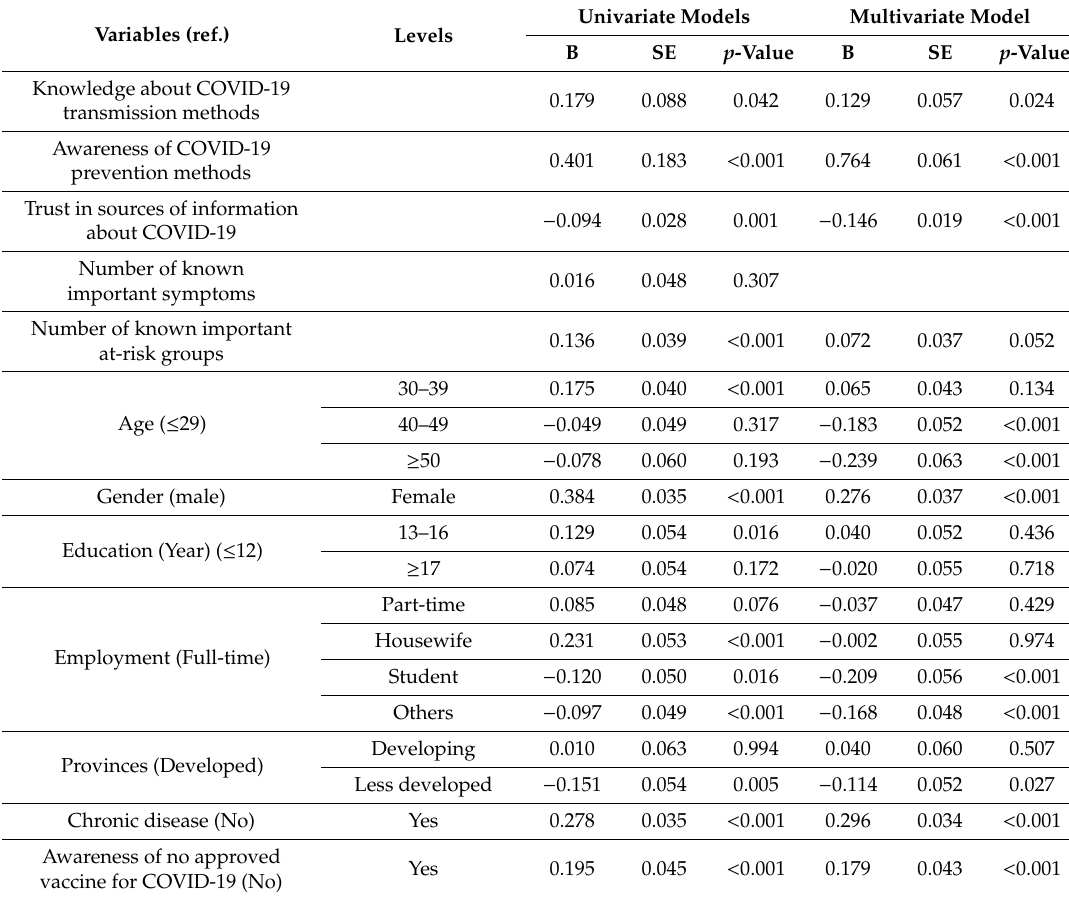
Table 2. Predictors of COVID-19-related stress in the general Iranian